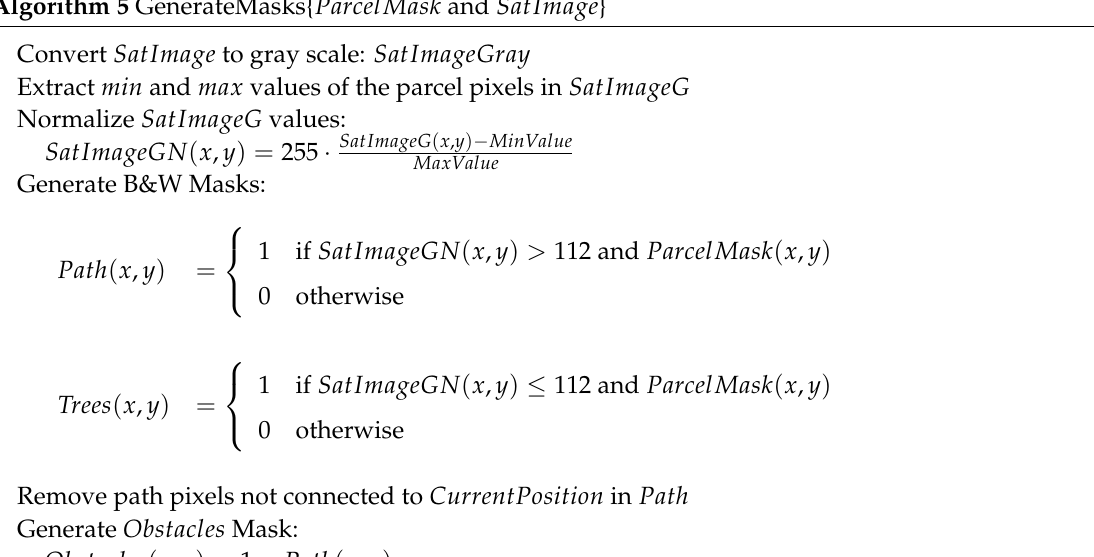
Algorithm 5 GenerateMasks{ ParcelMask and SatImage